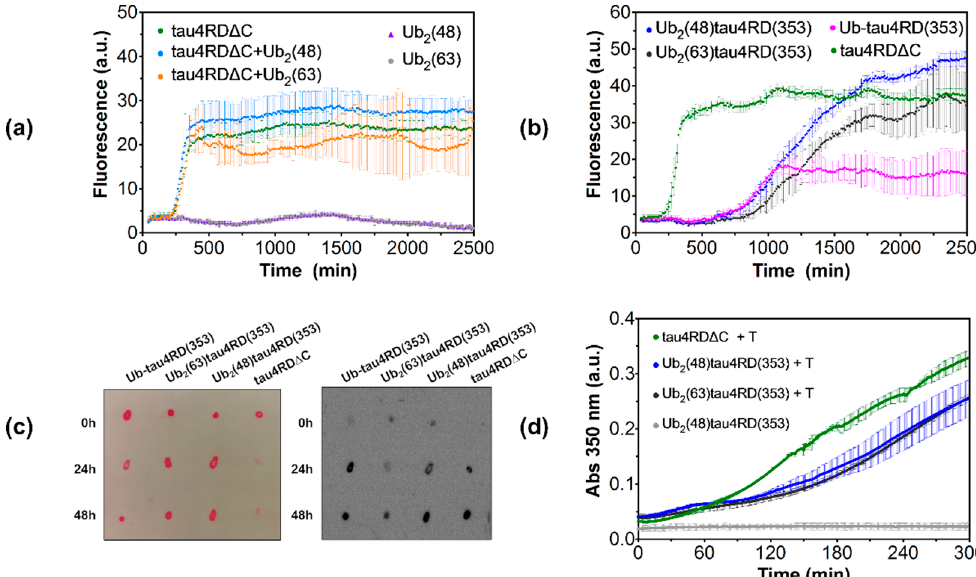
Figure 5. ( a , b ) Thioflavin T-based aggregation kinetics experiments. Error bars of fluorescence curves correspond to standard deviations of at least three independent experiments. In ( a ), aggregation data of tau4RD ∆ C are reported, in the absence or presence of equimolar Ub 2 (48 / 63). Kinetics data for the Ub 2 (48 / 63) alone are also reported. For these control experiments Ub 2 (48 / 63) were produced with a distal D77 ubiquitin mutant, to avoid insertion of free thiol groups. In ( b ), aggregation data of di-ubiquitinated forms Ub 2 (48)tau4RD(353) and Ub 2 (63)tau4RD(353) are reported in comparison with tau4RD ∆ C, and mono-ubiquitinated Ub-tau4RD(353). ( c ) On the right, dot Blot of Ub 2 (48)tau4RD(353) and Ub 2 (63)tau4RD(353) at different times of aggregation induced with equimolar heparin, probed with the A11 antibody. On the left, deposited proteins were stained with Ponceau. Samples of tau4RD ∆ C and Ub-tau4RD(353) were used as controls. ( d ) Microtubule assembly in the presence of tau protein samples was measured monitoring the absorbance at 350 nm. Error bars of absorbance curves correspond to standard deviations of three independent experiments. Ub 2 (48)tau4RD(353) sample in the absence of tubulin was used as control.